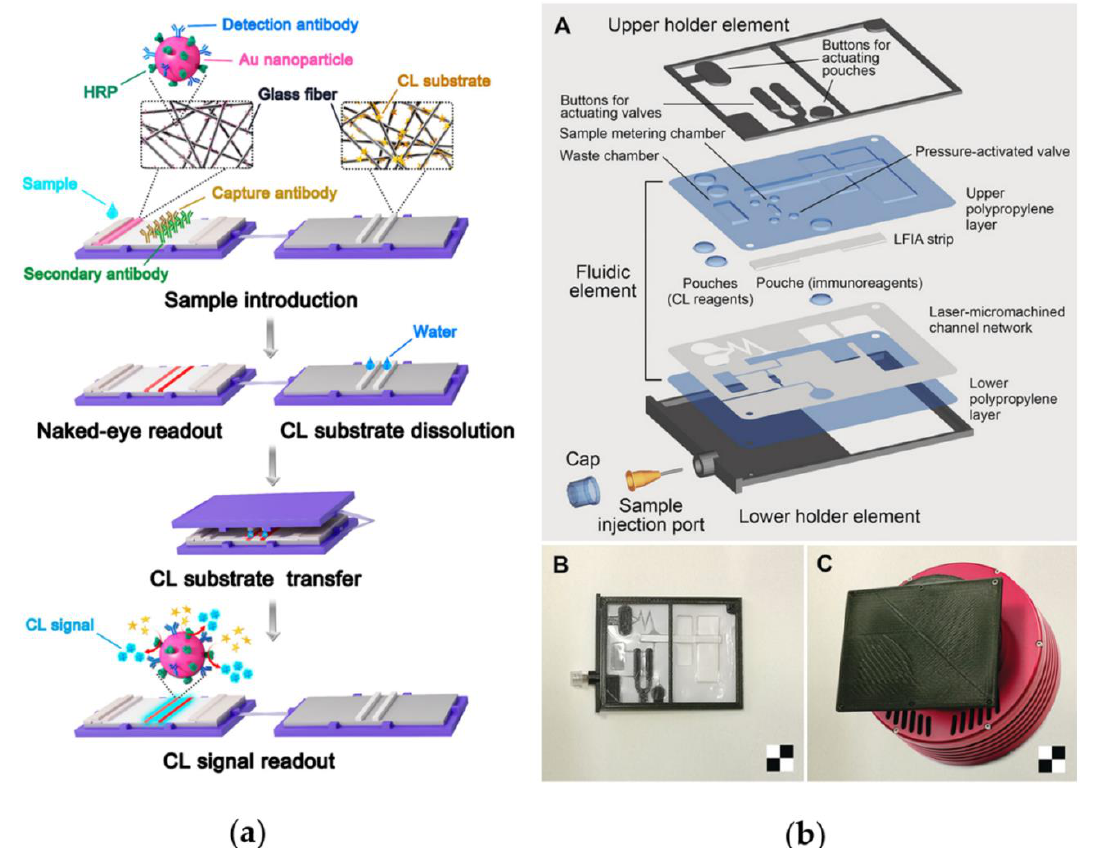
Figure 4. Self-contained devices for POC application: ( a ) a self-contained and easily processable CL lateral flow assay for POC testing. Reprinted with permission from ref. [64]. Copyright 2019 WILEY-VCH Verlag GmbH & Co. KGaA, Weinheim; ( b ) CL lateral flow immunoassay portable device to simultaneously detect two proteins (collagen and ovalbumin) for diagnostic campaigns on paintings: A) Layout and B) image of the disposable analytical cartridge; C) CCD camera with 3D-printed mini dark box. Scale checkerboard is 2×2 cm. Reprinted with permission from ref. [76]. Copyright 2018 Wiley-VCH Verlag GmbH & Co. KGaA, Weinheim .